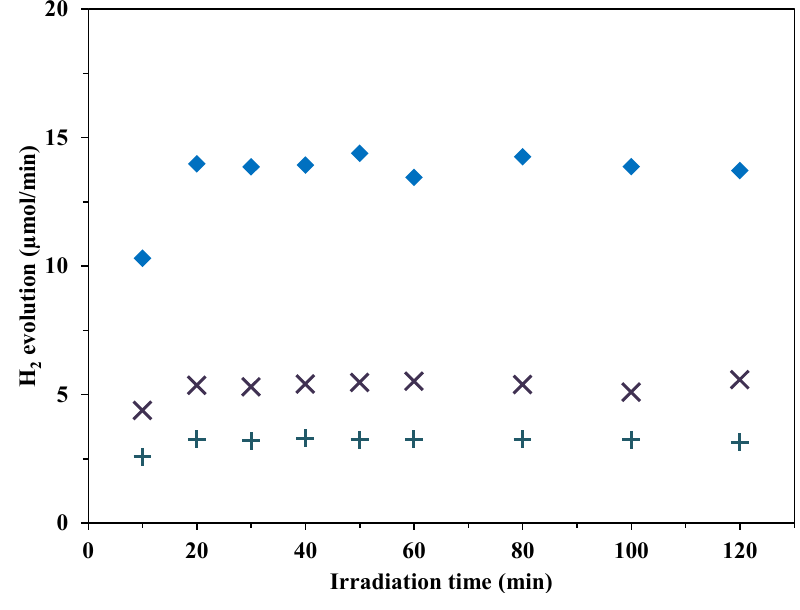
Figure 10. H 2 evolution from 50 mM oxalic acid, 50 mM and 100 mM methanol (initial concentrations), using Au-loaded P25-CRIS photocatalyst, D Au = 5.7 nm (♦ 50 mM oxalic acid, + 50 mM methanol, × 100 mM